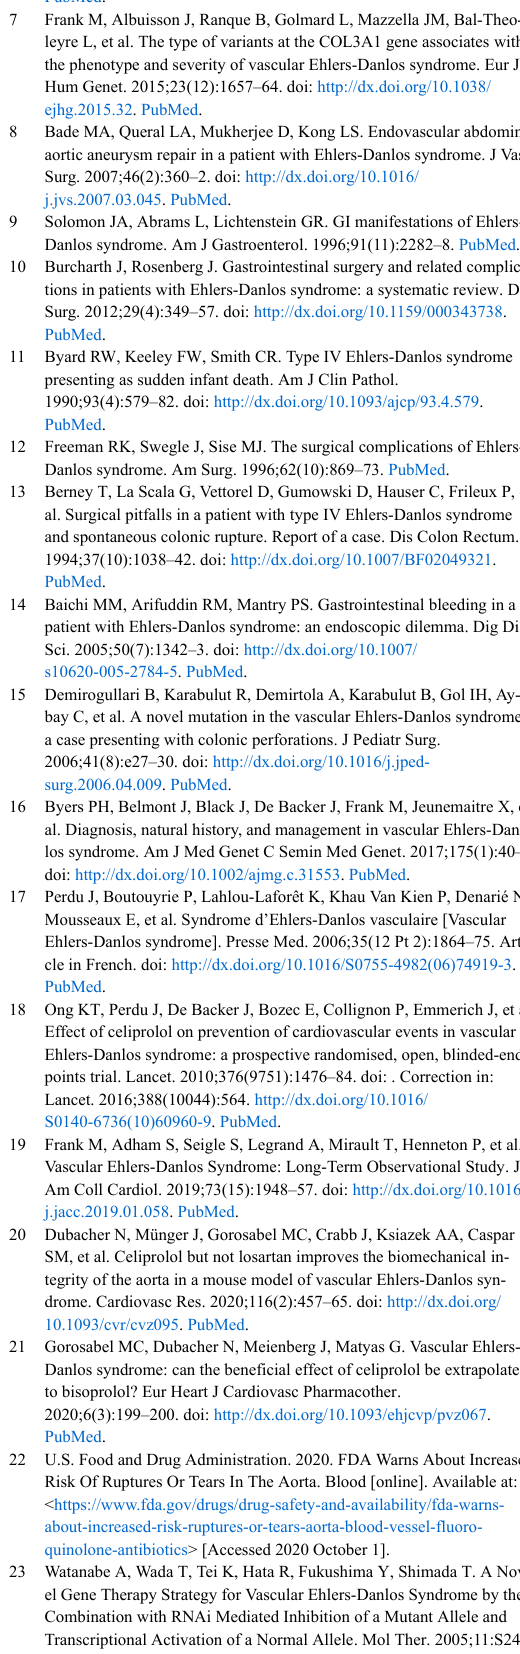
Figure 7: Follow-up abdominal CT scan after balloon angioplasty showing an excellent result.